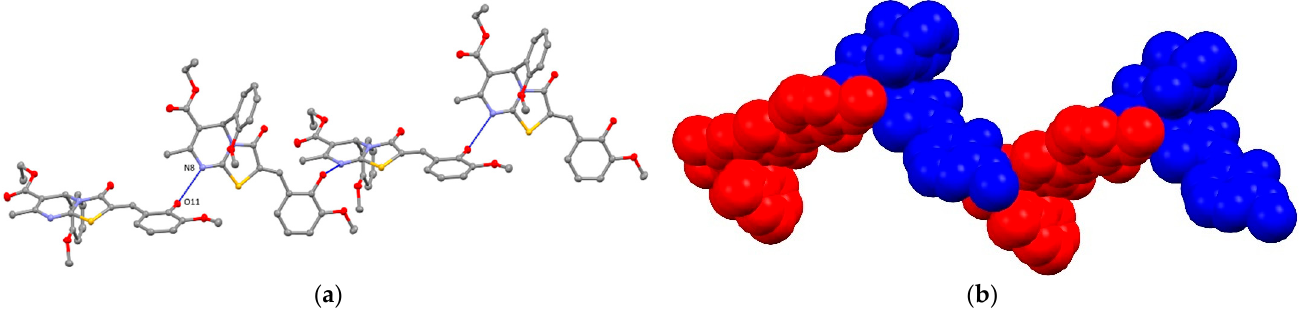
Figure 4. ORTEP-view of supramolecular 1D chains resulting from intermolecular H-bonding in the crystals of compound 3 ( a ); R- and S- isomers colored blue and red, respectively ( b ). The ellipsoids are presented with 50% probability and the H-atoms are omitted for clarity. H-bonding is presented by blue dotted lines.